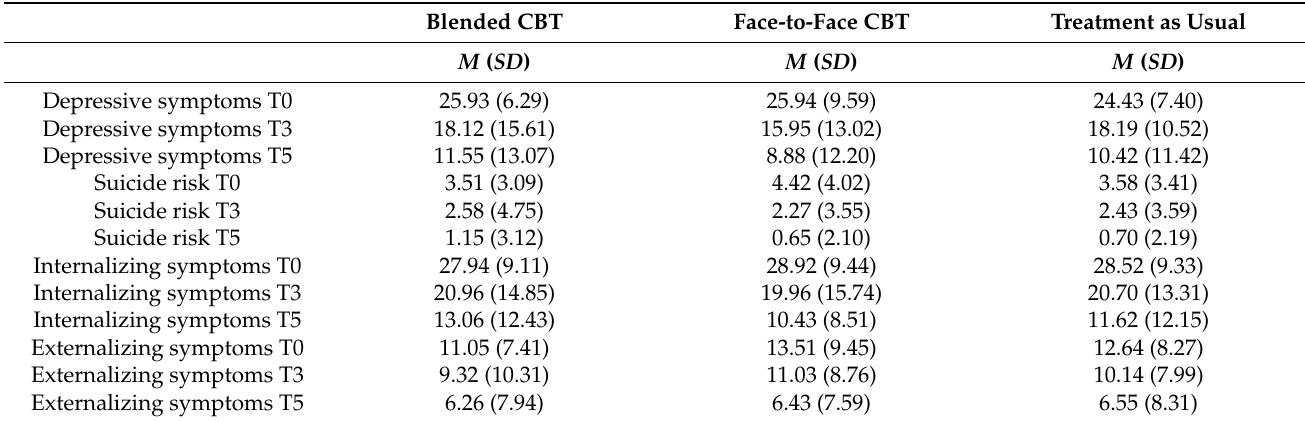
Table 1. Means and standard deviations of secondary outcomes depressive symptoms, suicide risk, internalizing symptoms and externalizing symptoms at baseline (T0), post-treatment (T3) and 12-month follow-up (T5).